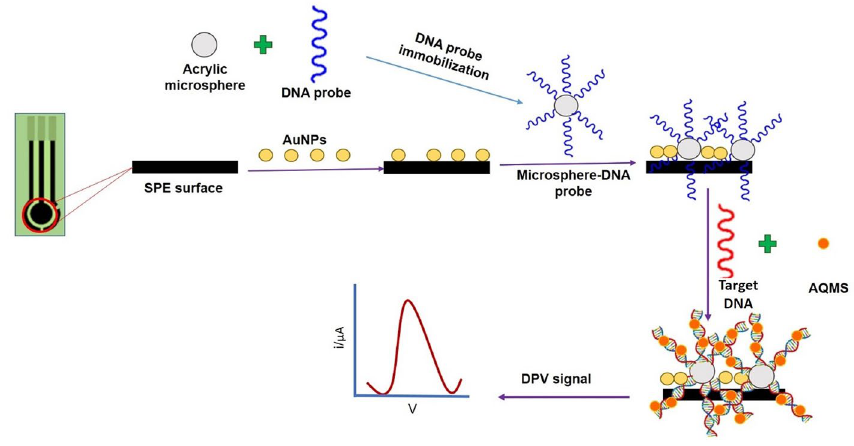
Figure 6. The schematic diagram of electrochemical DNA biosensor based on acrylic microsphere-gold nanoparticle for the determination of MK durian